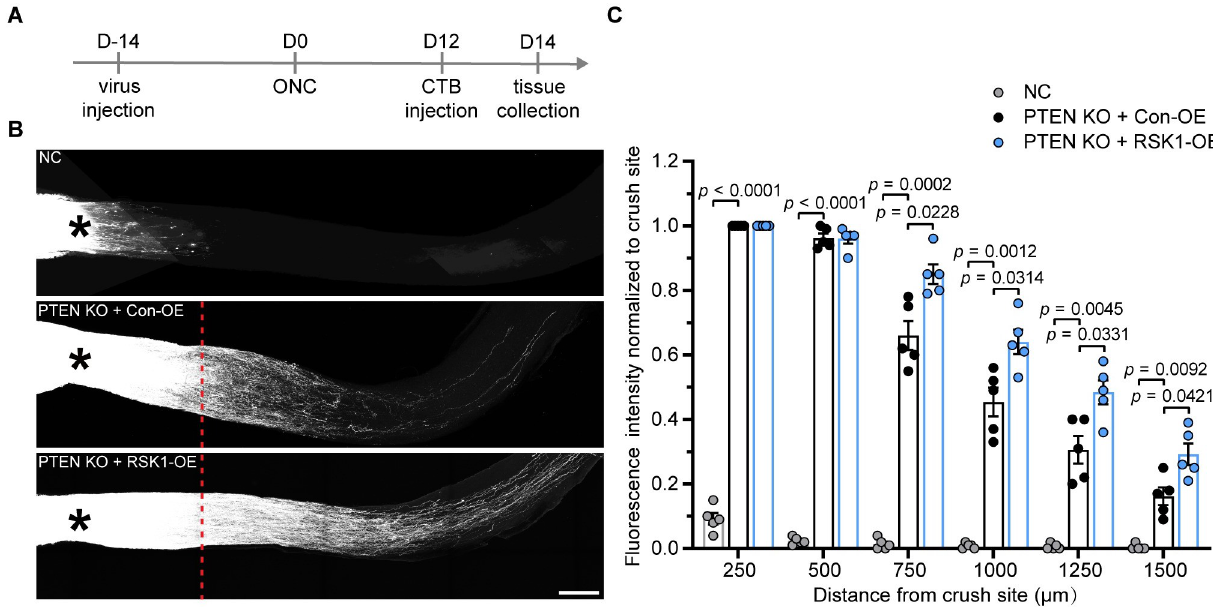
Fig 8. RSK1 enhances PTEN deletion-induced axon regeneration of retinal ganglion neurons in the adult mouse. (A) Timeline for AAV2 injection, ONC injury, and CTB injection. (B) Representative images of the cleared whole-mount optic nerves from Rosa26-Cas-9 mice 2 weeks postinjury. AAVs with EGFP only (NC), or AAVs with gRNA targeting PTEN (AAV-PTEN-gRNA) combined with AAV expressing RSK1 (RSK1-OE) or empty AAV (Con-OE) were intravitreally injected into Rosa26-Cas-9 mice. Axons were labeled by AF 555-conjugated CTB. The crush site is indicated by an asterisk, and the position where PTEN KO+RSK1-OE and PTEN KO+Con-OE conditions start to show differences is indicated by a red dotted line. Scale bar, 200 μ m. (C) Normalized fluorescence intensity plotted in function of the distance from the crush line (mean ± SEM, 2-way ANOVA, Tukey post hoc test, n = 5 mice per group). The data underlying all the graphs shown in the figure are included in S1 Data. AF, Alexa Fluor; CTB, cholera toxin B subunit; gRNA, guide RNA; KO, knockout; ONC, optic nerve crush; PTEN, phosphatase and tensin homolog; RSK1, ribosomal S6 kinase 1; SEM, standard error of the